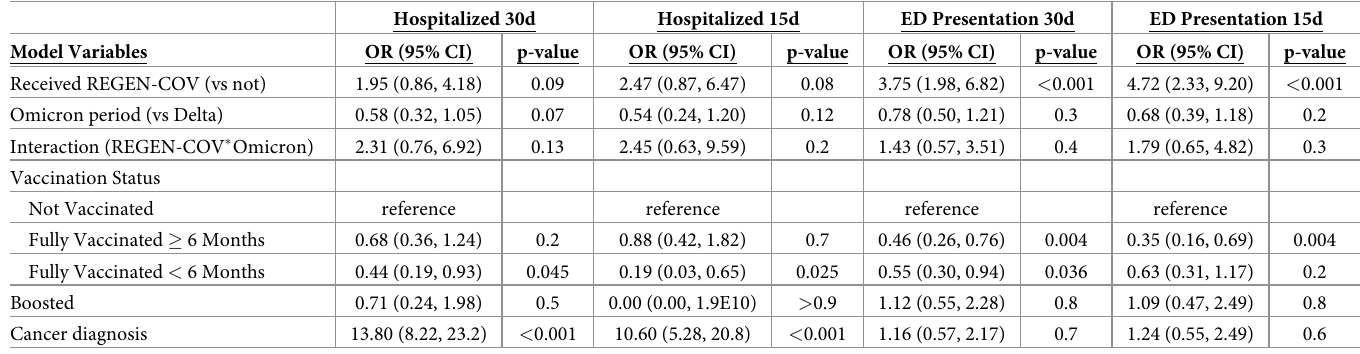
Table 3. Adjusted associations of time period, REGEN-COV, and the interaction with